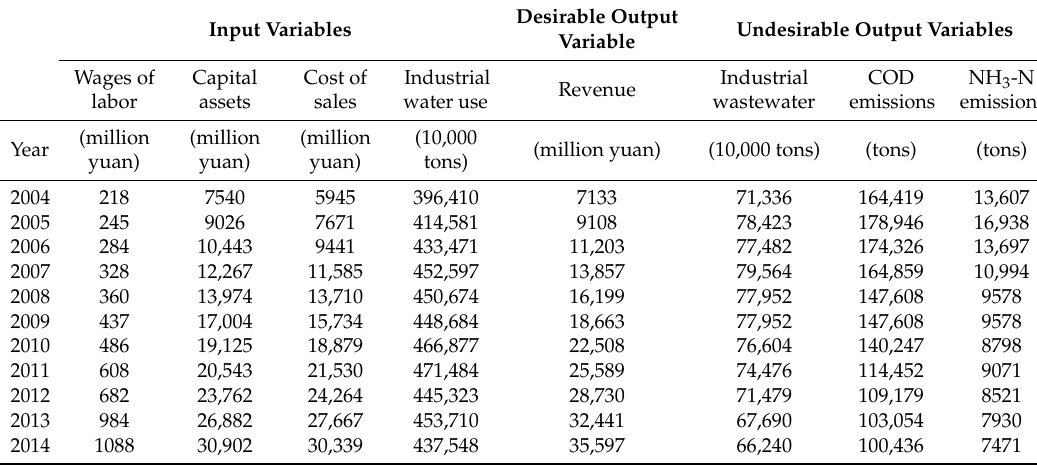
Table 1. Descriptions of variables used in efficiency measurements.